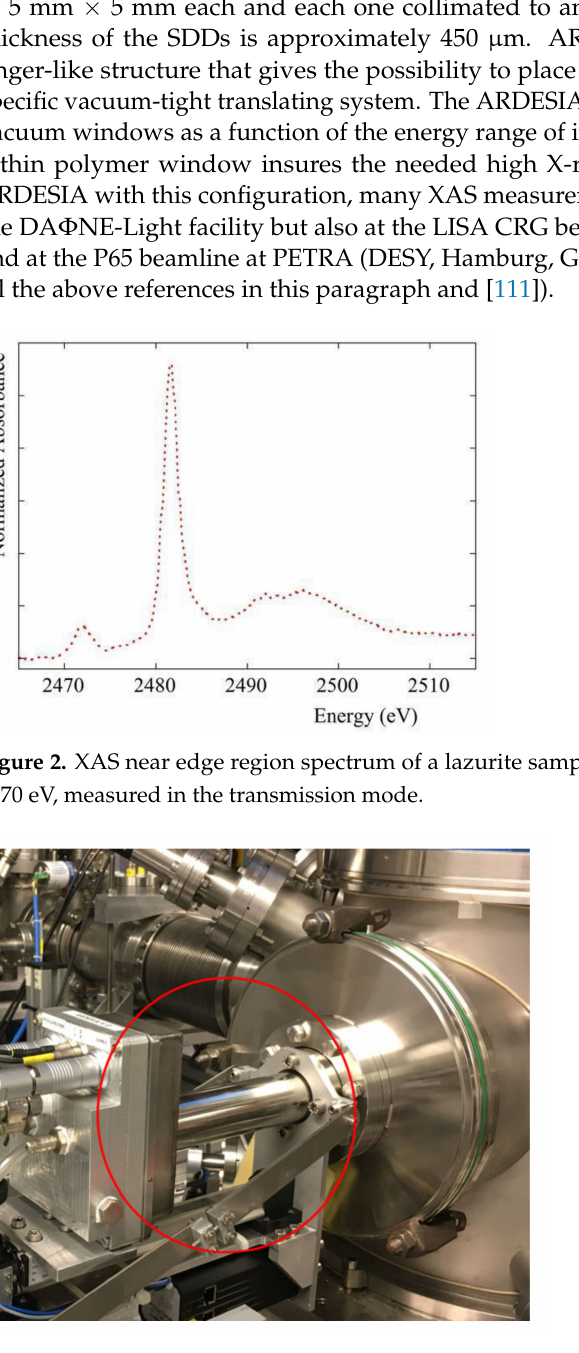
Figure 3. The ARDESIA four-channel SDD detector installed on the experimental chamber of a synchrotron radiation beamline. Its finger-like structure, visible in the red circle, makes its use in vacuum-tight chambers